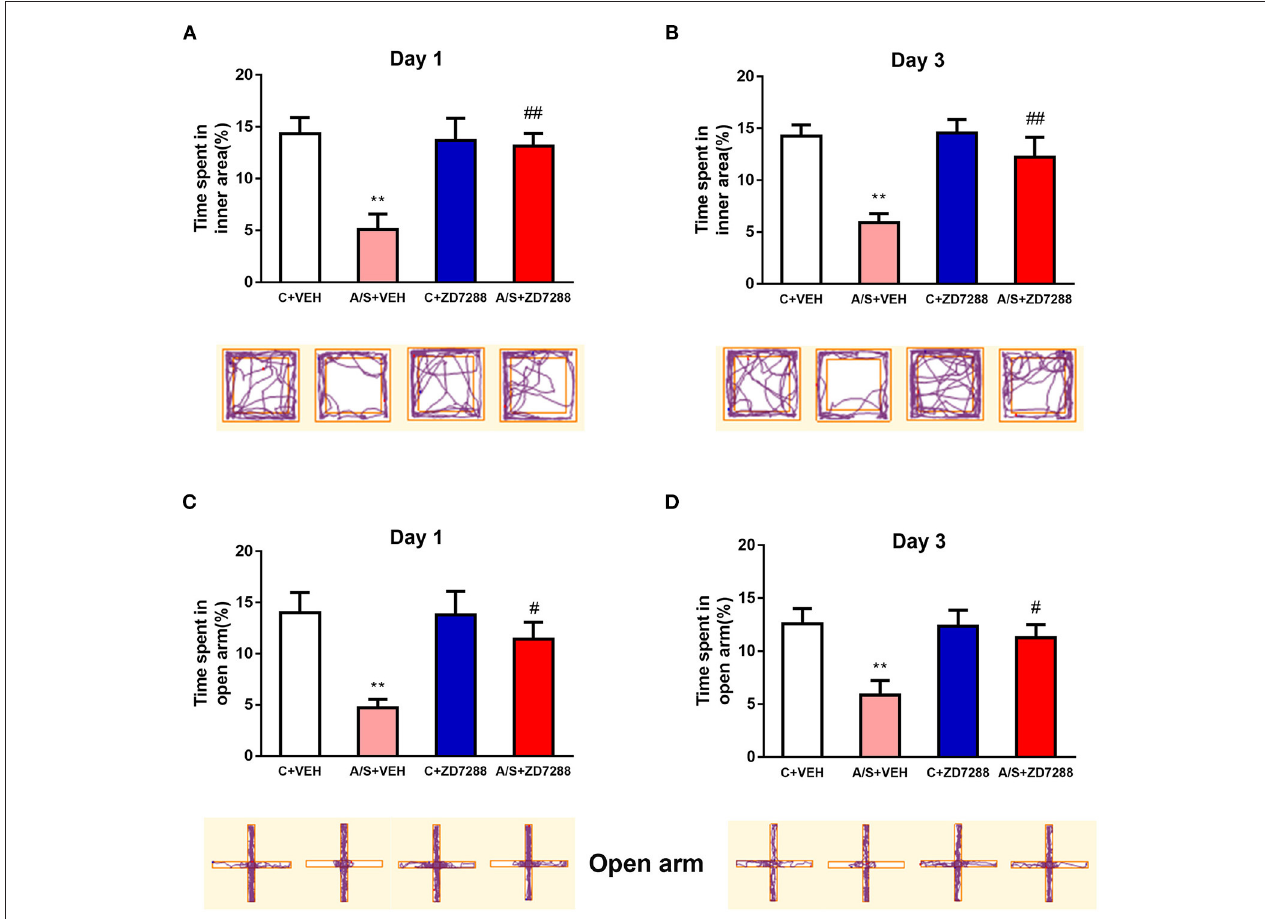
FIGURE 8 | Effect of the HCN1 inhibitor on anxiety-like behavior induced by anesthesia/surgery. (A,B) The percent time spent in inner area and movement trace of the OFT among the 4 groups. (C,D) The percent time in open arm and movement trace of the EPM among the 4 groups ( n = 10 per group, * p < 0.05; ** p < 0.01; # p < 0.05; ## p < 0.01). Data are presented as the means ±